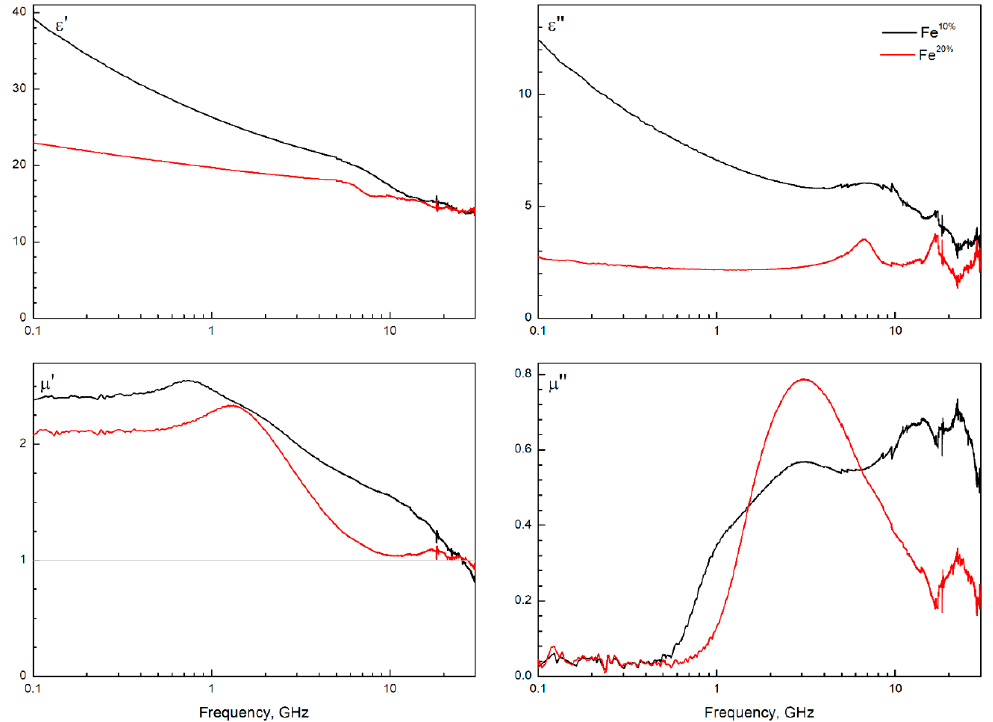
Figure 6. The measured frequency dependences of microwave permeability ( μ′ +i × μ″ ) and permit- tivity ( ε′ + i × ε″ ) of the composites comprising powders Fe 10% or Fe 20% , and paraffin wax matrix. The curves are normalized by weight ratio 3:1 between metallic powder (Fe 10% , Fe 20% ) and wax matrix.